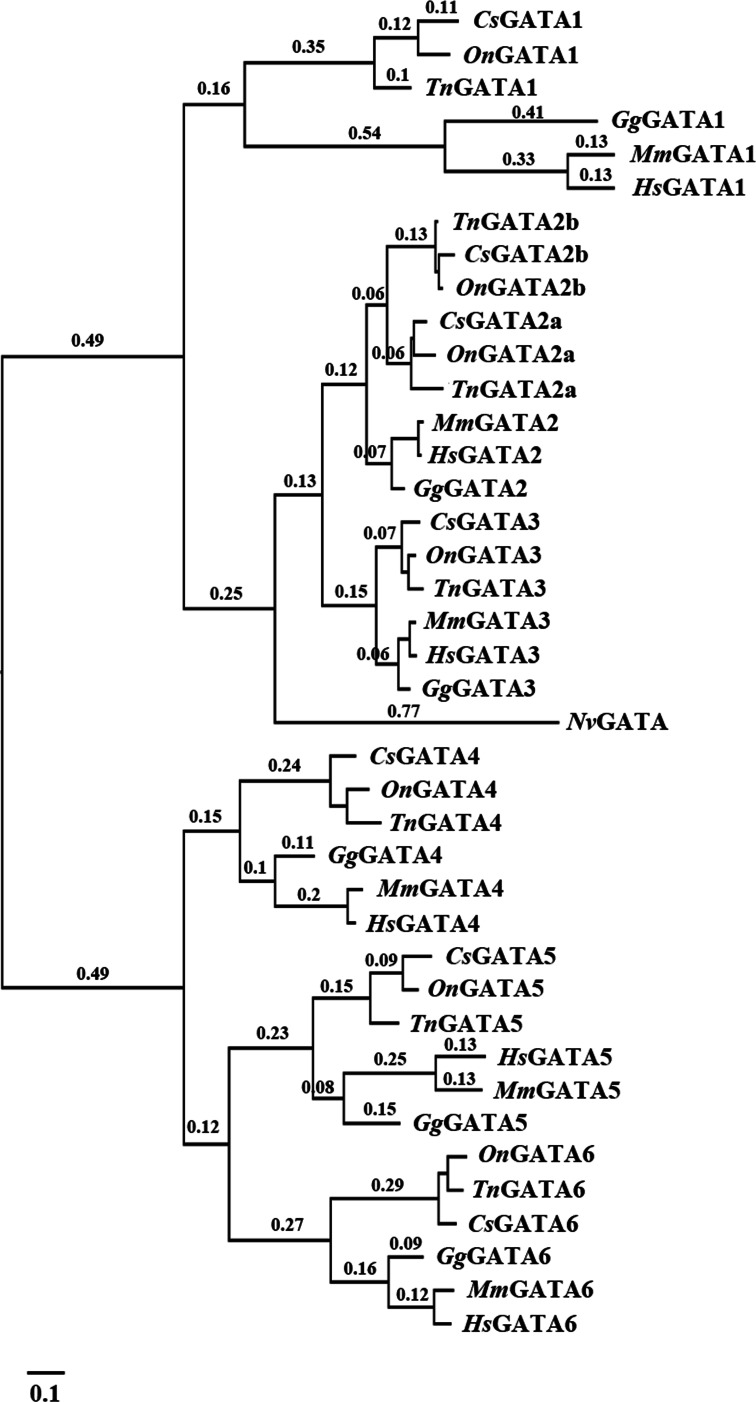
Phylogenetic analyses of vertebrate GATA gene family.Phylogenetic tree constructed using MrBayes with the TPM1uf + I + G model; MCMC = 400,000 generations. On, Oreochromis niloticus; Cs, Cynoglossus semilaevis; Tn, Tetraodon nigroviridis; Mm, Mus musculus; Gg, Gallus gallus; Hs, Homo sapiens; Nv, Nematostella vectensis.